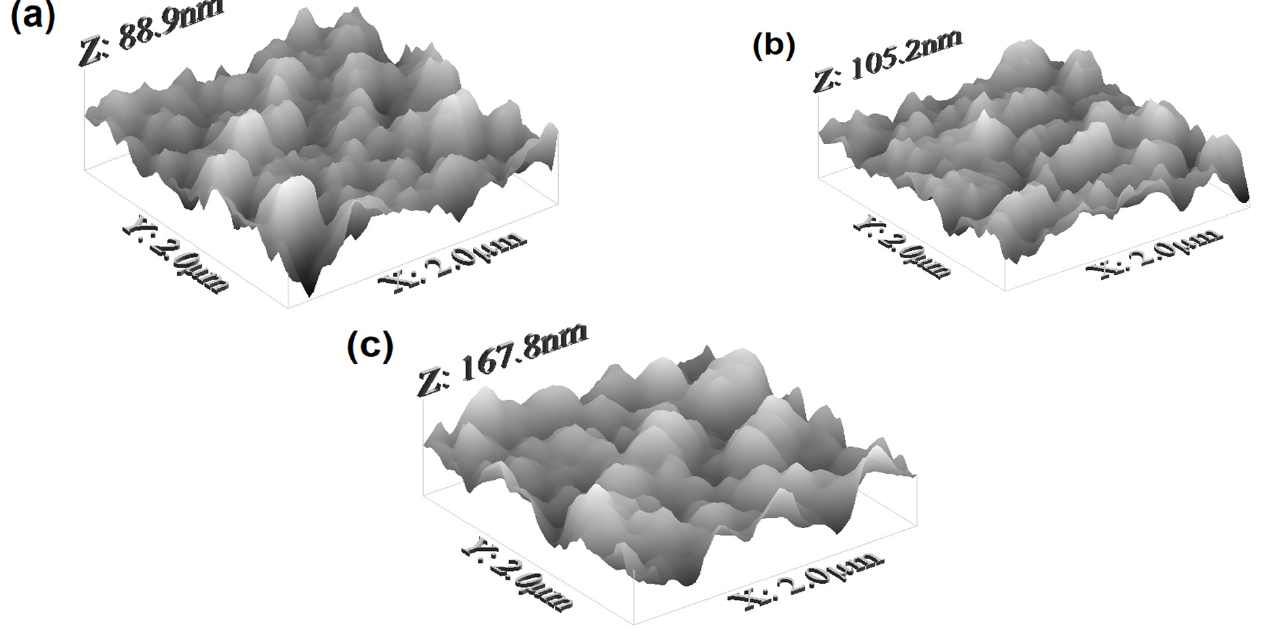
Figure 6. AFM images of the samples ( a ) Fe–Co 33 –Ni 62 , ( b ) Fe–Co 43 –Ni 53, and ( c ) Fe–Co 61 –Ni 36 , respectively.